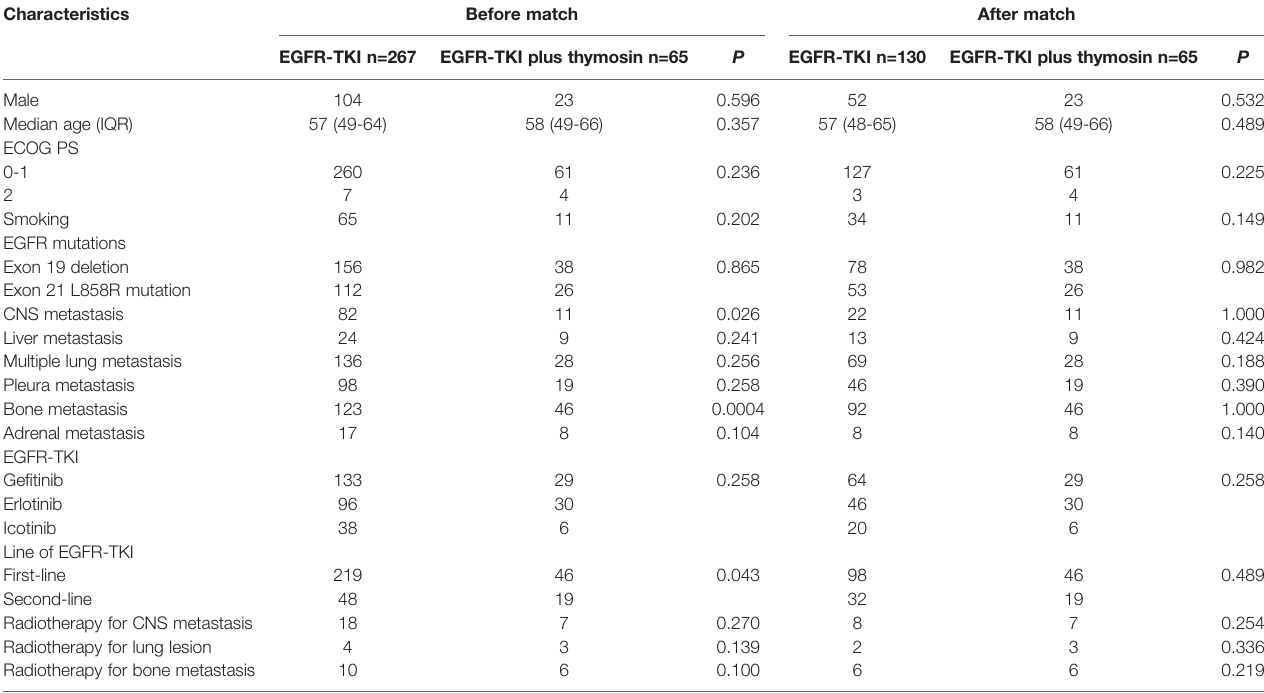
TABLE 1 | Patients ’ demographic and clinical characteristics in the EGFR-TKI and EGFR-TKI plus thymosin group before and after propensity score matching.